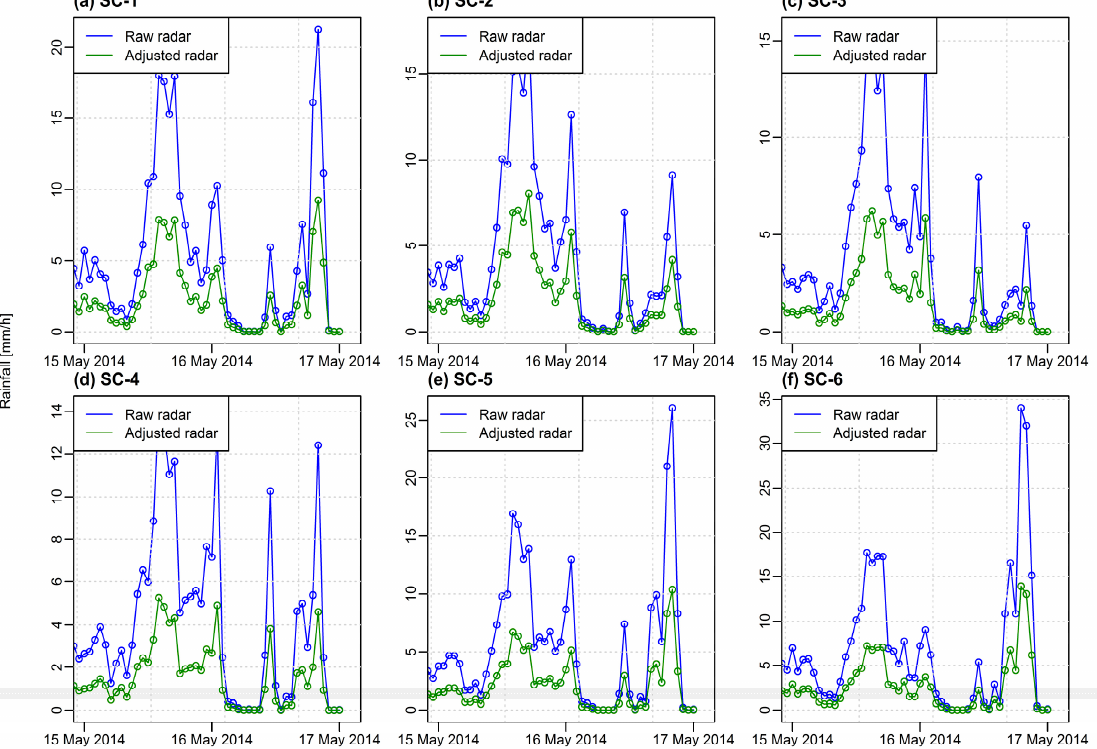
Figure 3. Comparison of raw and adjusted radar rainfall estimates for Event 1 (adapted to the period of significant precipitation): ( a ) SC-1; ( b ) SC-2; ( c ) SC-3; ( d ) SC-4; ( e ) SC-5; ( f ) SC-6.